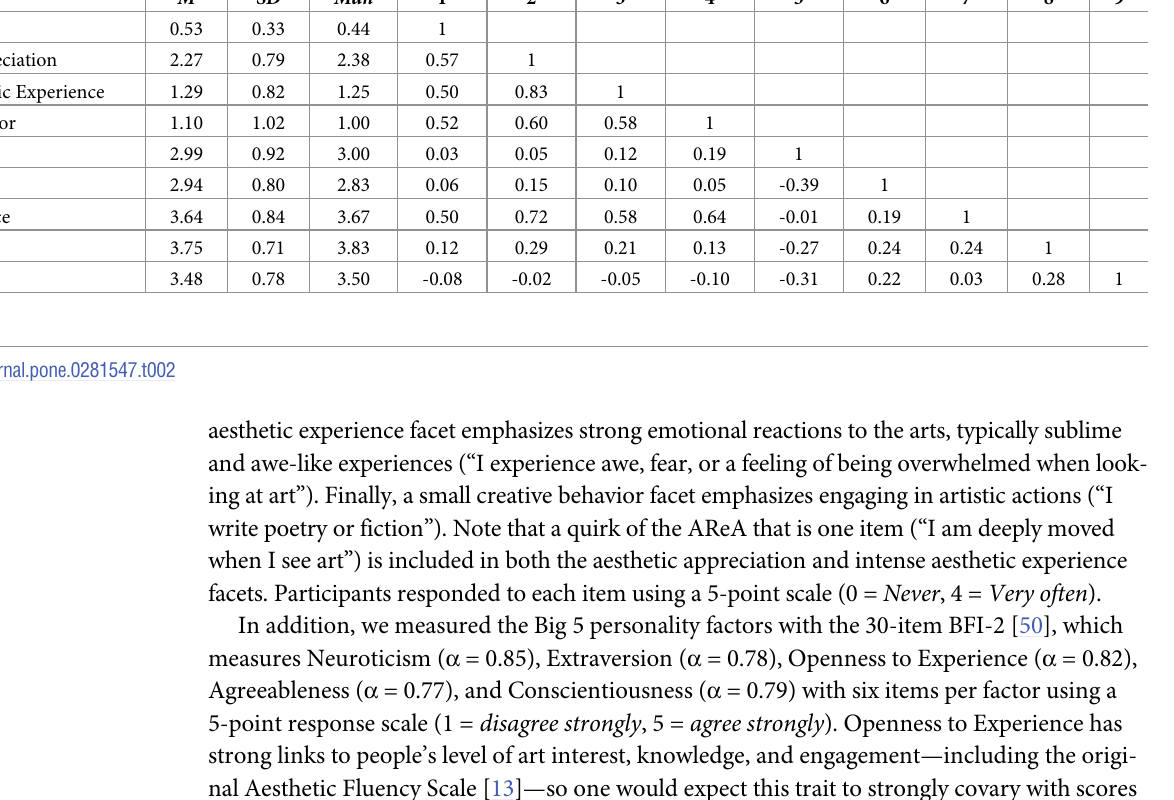
Table 2. Descriptive statistics and correlations: Study 2.